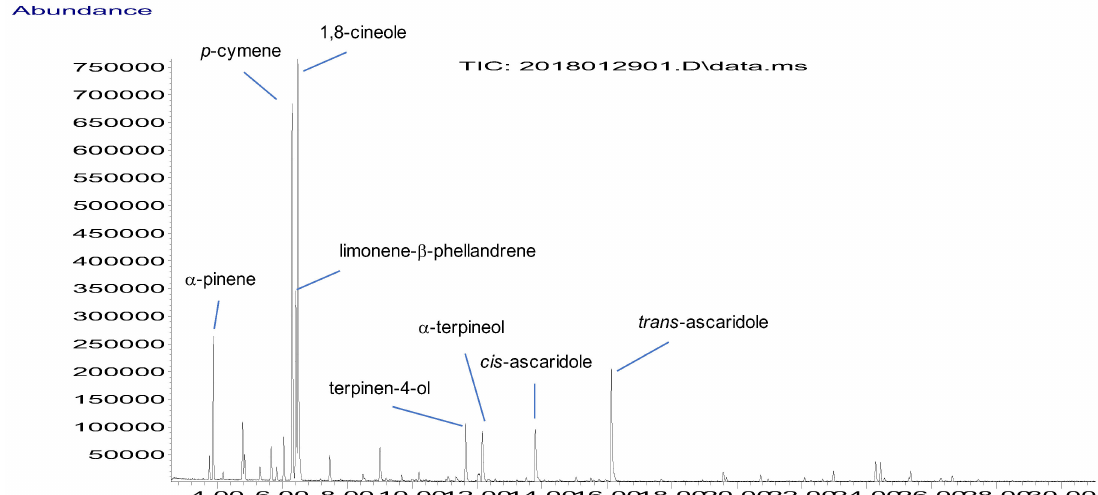
Figure 1. Gas chromatography-mass spectrometry (GC-MS) chromatogram of Peumus boldus leaf essential